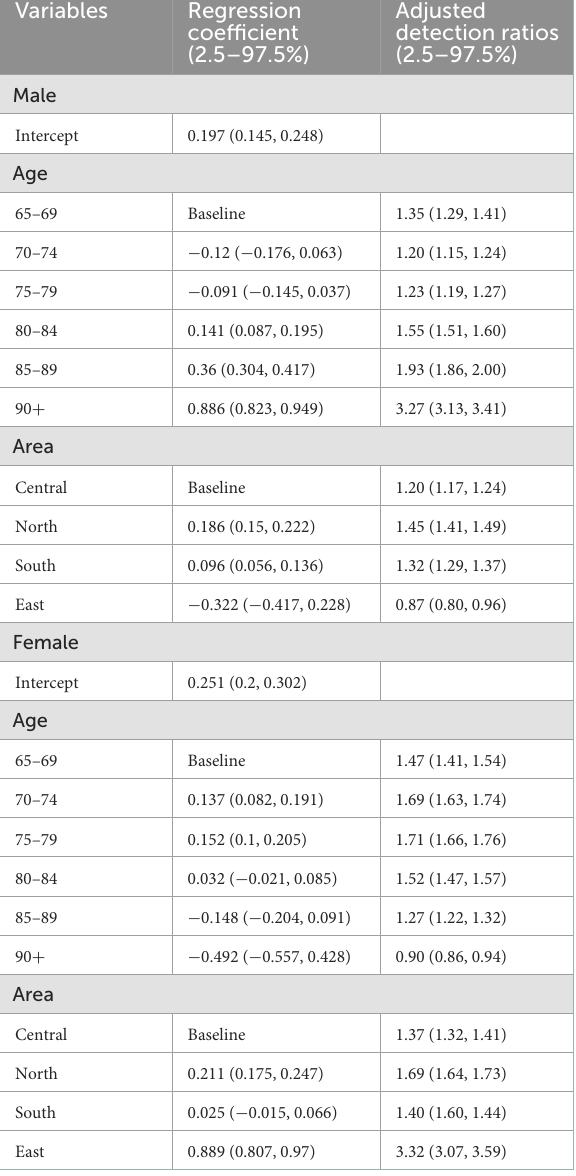
TABLE 4 Adjusted detection ratios of dementia in comparison between passive and active survey.